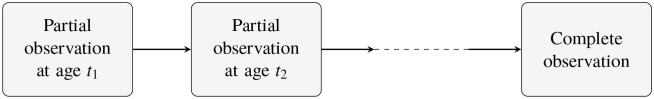
Partial observations growing with event-age.